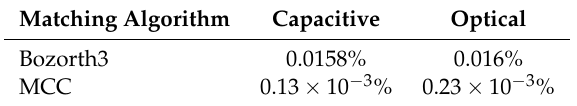
Table 2. Probability value of a successful attack FAR A for each sensor type for the two matching algorithms. Matching